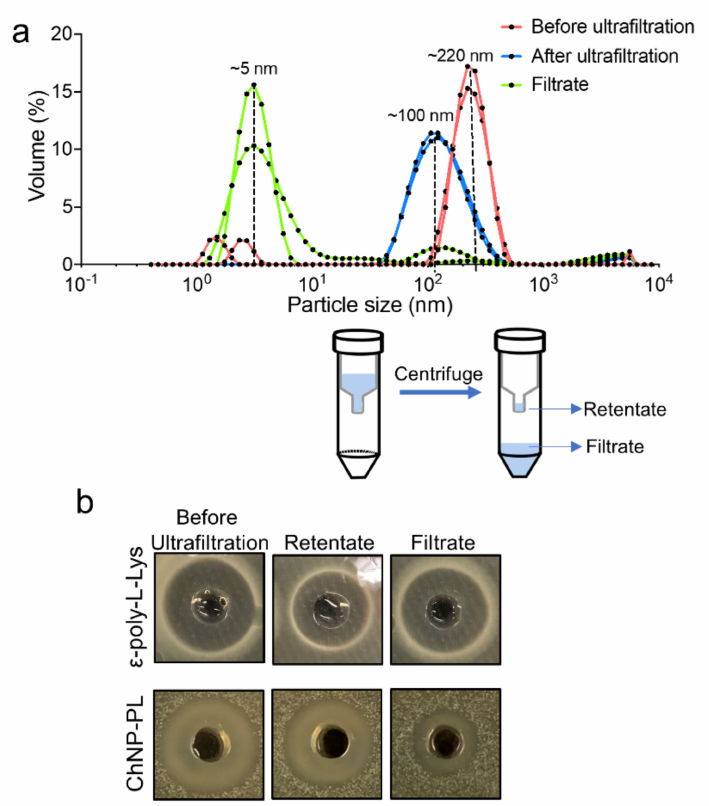
Figure 1. Synthesis and characterization of chitosan nanoparticles (ChNP) and ChNP conjugated to ε -poly-L-Lysine (ChNP-PL). ( a ) Size comparison of ChNP synthesized with or without 1% PL. (Bottom) Removal of unbound PL after ChNP-PL synthesis by ultrafiltration (30 kDa cut-off). ( b ) ChNP-PL and PL-mediated inhibition of L. monocytogenes F4244 in soft BHI agar, demonstrating the antimicrobial activity of